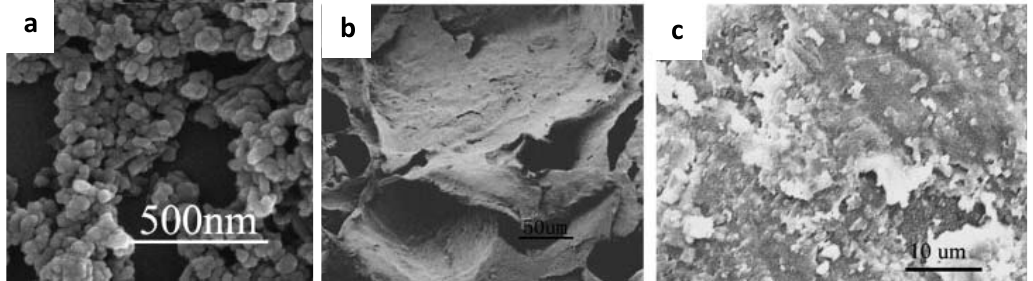
Figure 15. ( a ) ESEM micrograph of bioactive glass nanoparticles sintered for 3 h at 600 °C; ( b ) The scaffold morphology: PLLA for 7 days; ( c ) g-bioactive glass/PLLA composite for 7 days. Reproduced from [33] with permission from